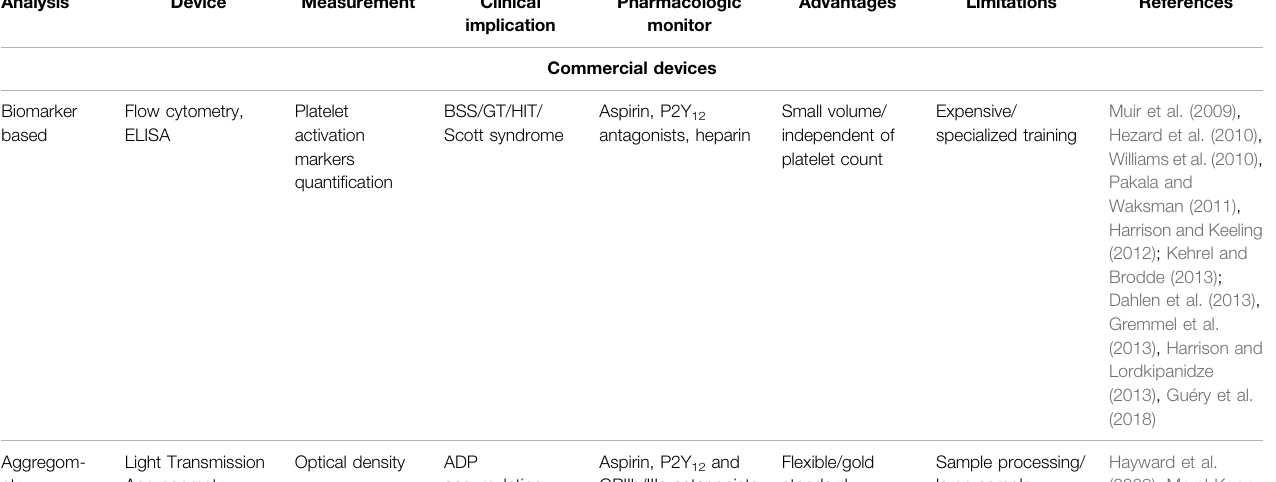
TABLE 1 | A summary of conventional assays and the novel micro fl uidic devices for platelet function analysis and antiplatelet drug